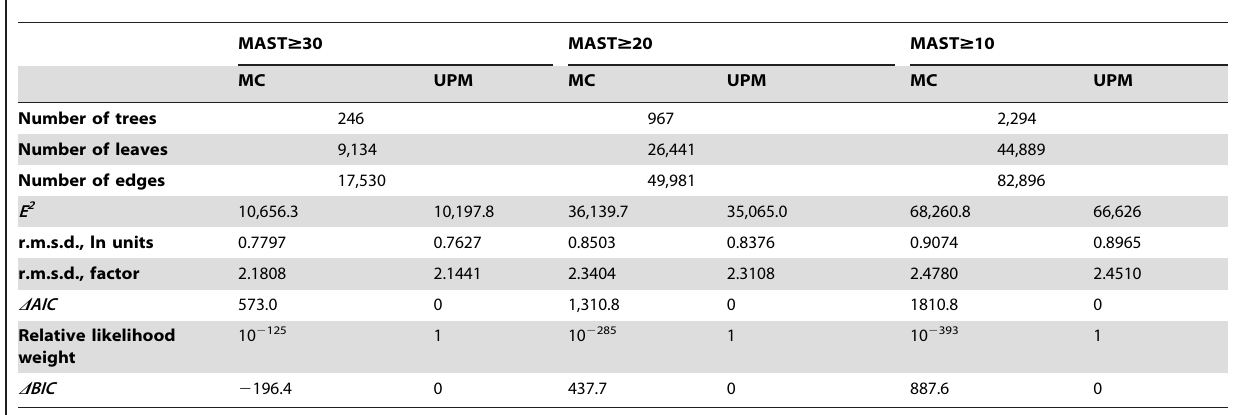
Table 1. Comparison of the Molecular Clock and Universal Pacemaker models of genome